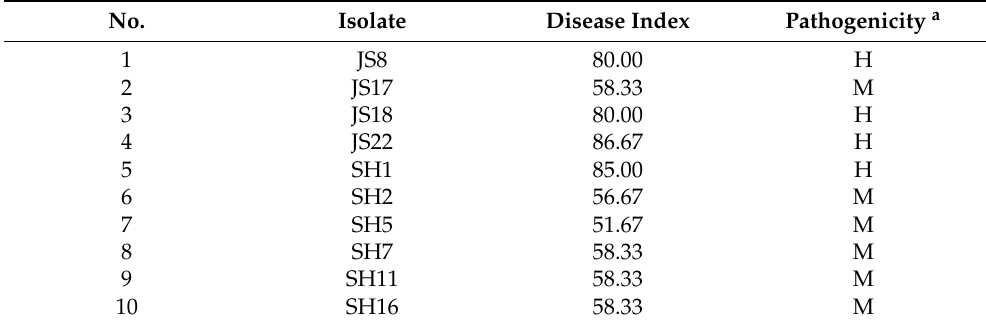
Table 2. Pathogenicity of isolates of Pythium aristosporum isolated from rice seedlings in Heilongjiang province, China.